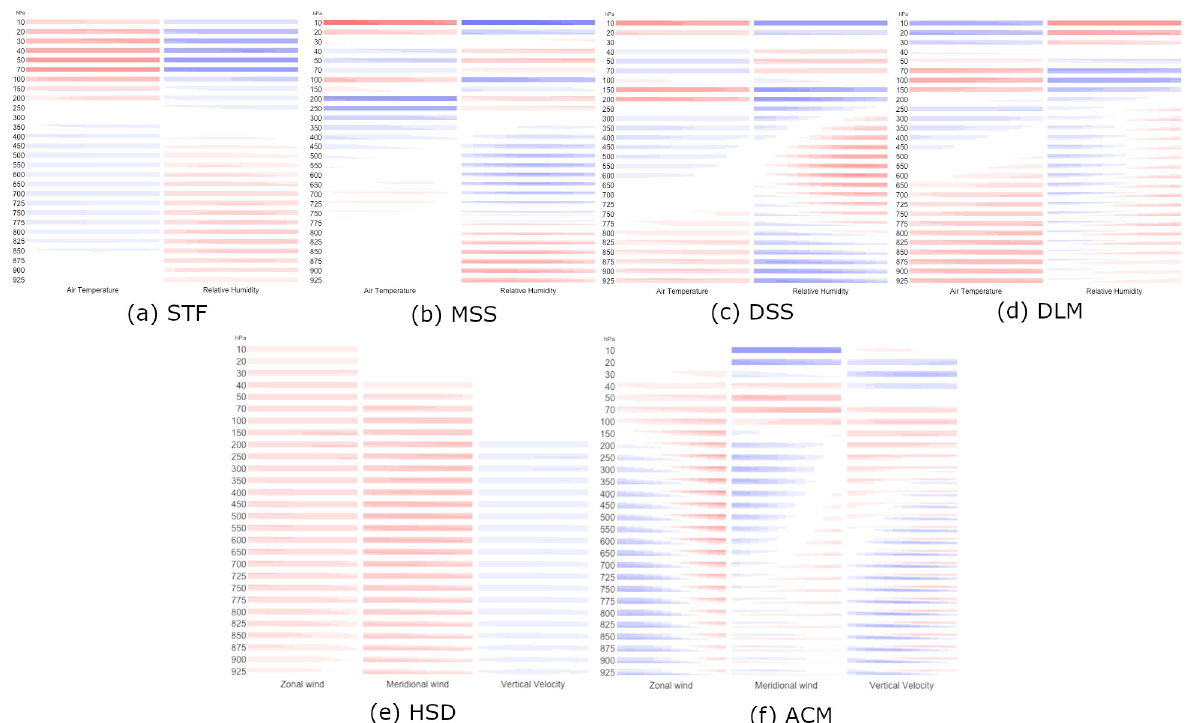
Fig 2. Plots for the spatial loadings of important weather EOFs at different altitude pressure levels. Within each panel, each column corresponds to one weather variable and each row corresponds to one altitude pressure level. Each rectangle maps spatially the 182 loadings, one for each MERRA-2 data location in Fig 1. Colors indicate sign and magnitude of the loadings: red for positive and blue for negative loadings; darker colors for larger magnitude, and white for negligible loadings. (a) STF, (b) MSS, (c) DSS, (d) DLM, (e) HSD, and (f) ACM.